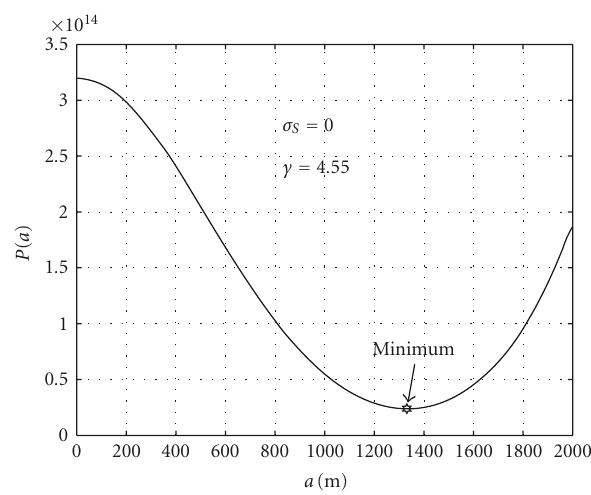
Figure 2: Numerical result of P ( a ) for γ = 4 . 55 and σ s = 0.